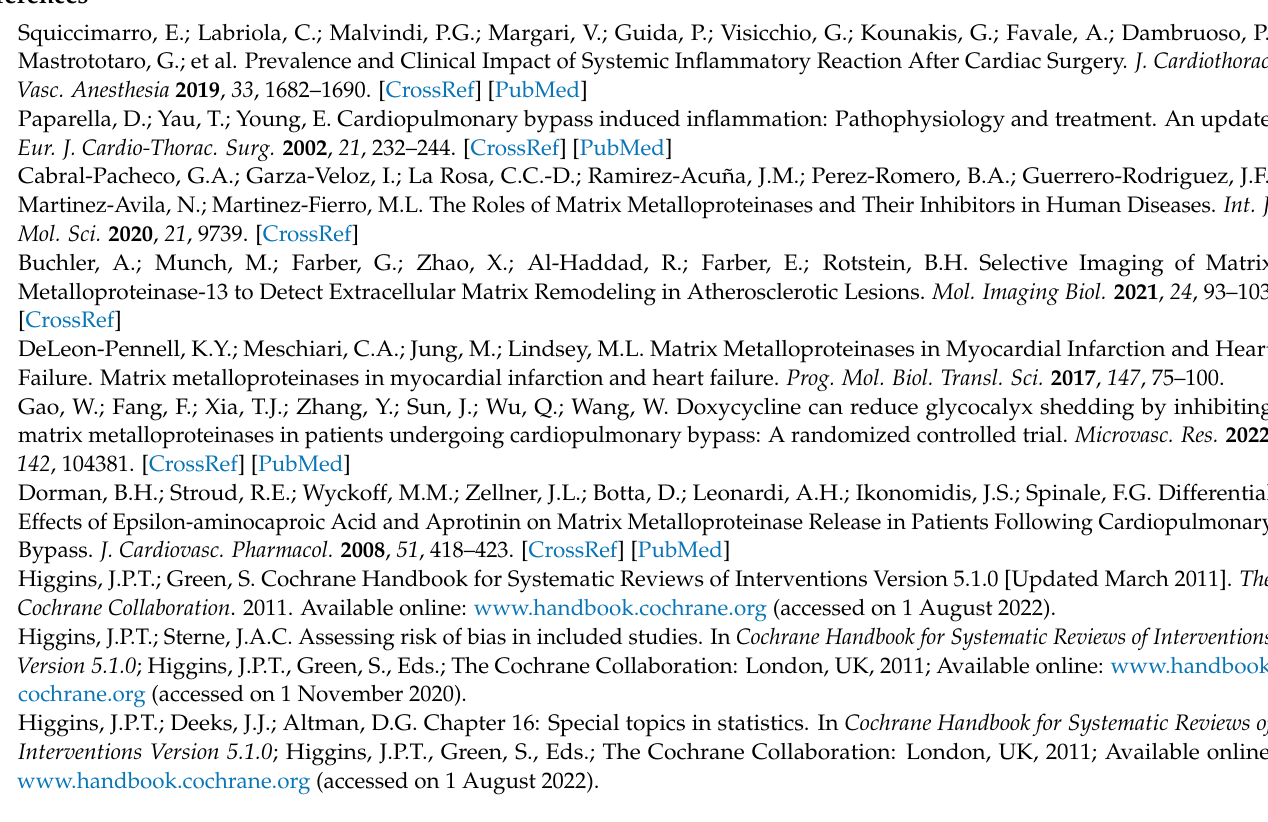
studies; Figure S3: Risk of bias summary: review authors’ judgements about each risk of bias item for each randomized included study. Table S1: PICo criteria for inclusion and exclusion of studies; Table S2: Quality scoring for included papers using Newcastle–Ottawa Scale; Table S3: Characteristics of excluded studies. Commentary S1. Assessment of publication bias for